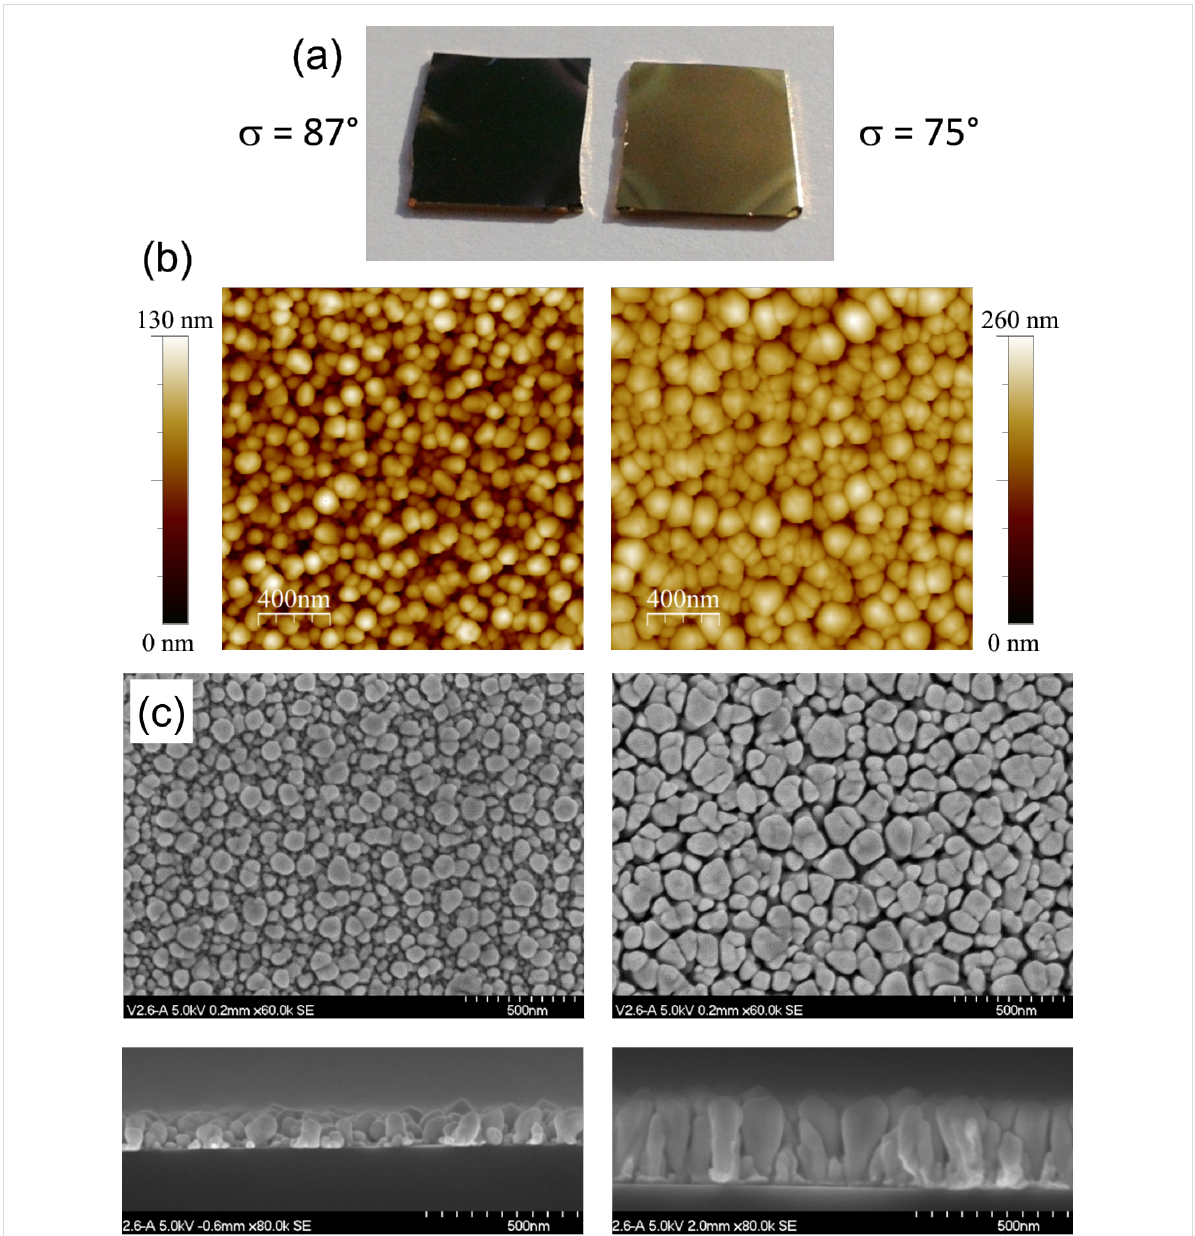
Figure 2: (a) Photograph, (b) AFM images, and (c) SEM images (upper row: top view, lower row: fracture cross section) of two Au samples prepared onto Si substrates with σ = 87° (left column) and σ = 75° (right column).